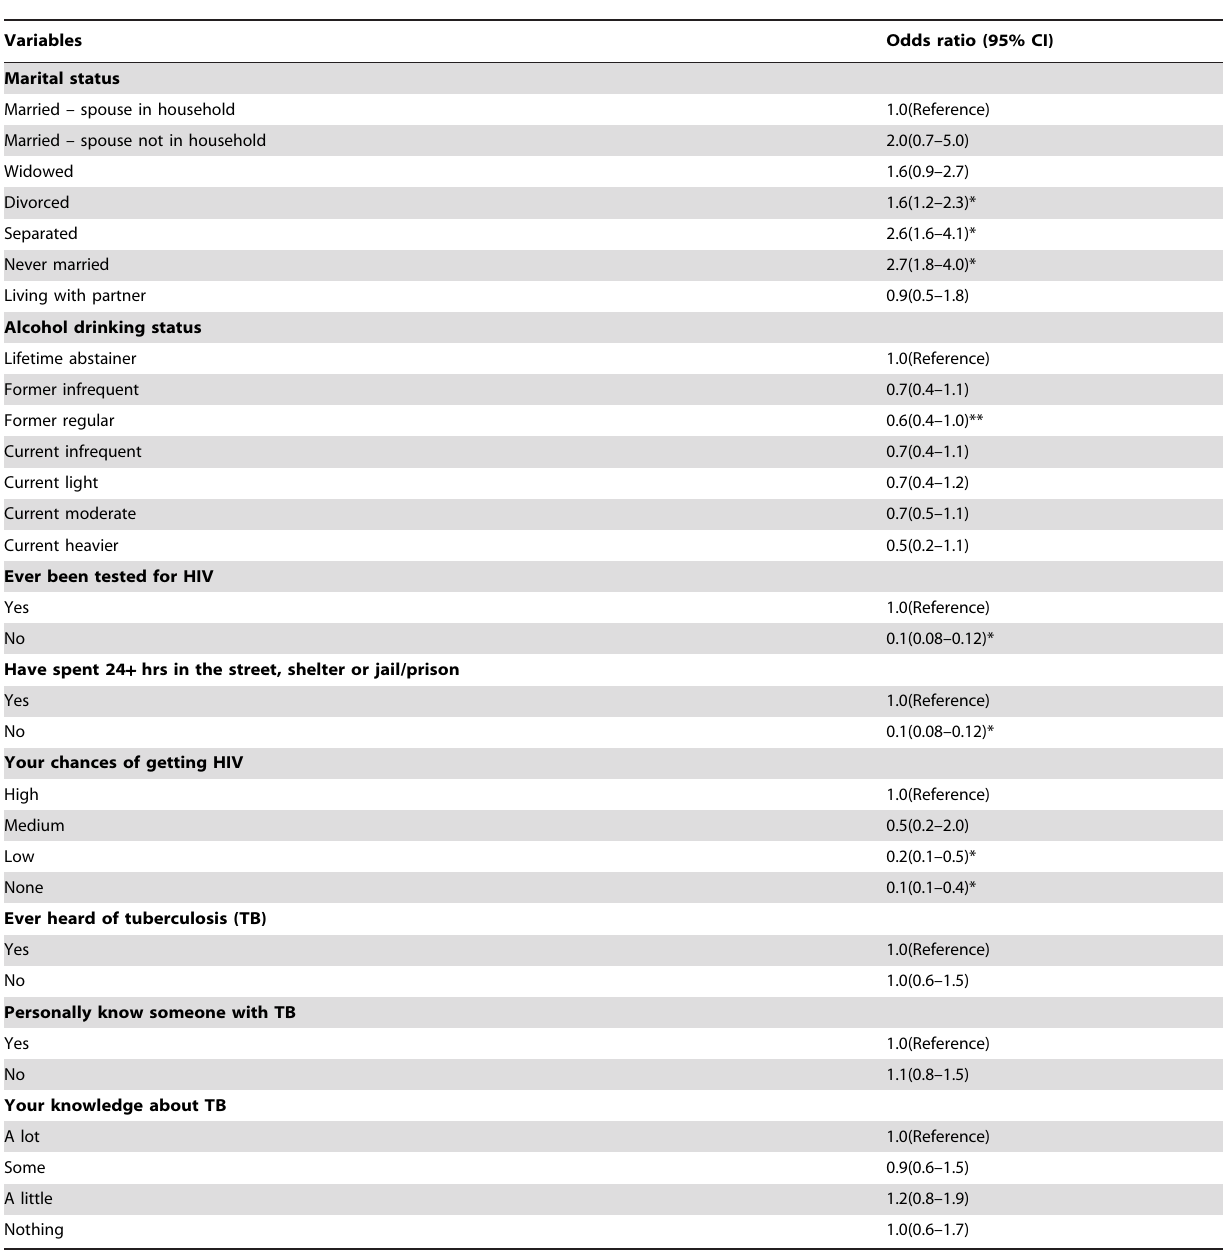
Table 5. Multiple logistic regression model showing the odds of getting an HIV test in the next 12 month adjusted for sex, race, Medicare type, health insurance coverage status, and physical health